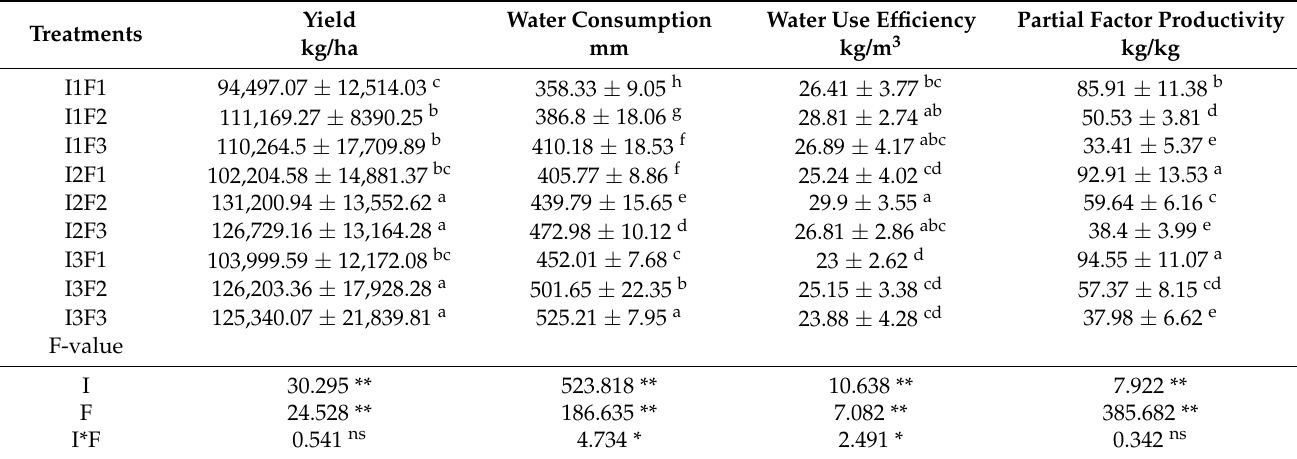
Table 6. Effect of integrated water and fertilizer on the yield and water use efficiency of tomatoes by moistube irrigation in